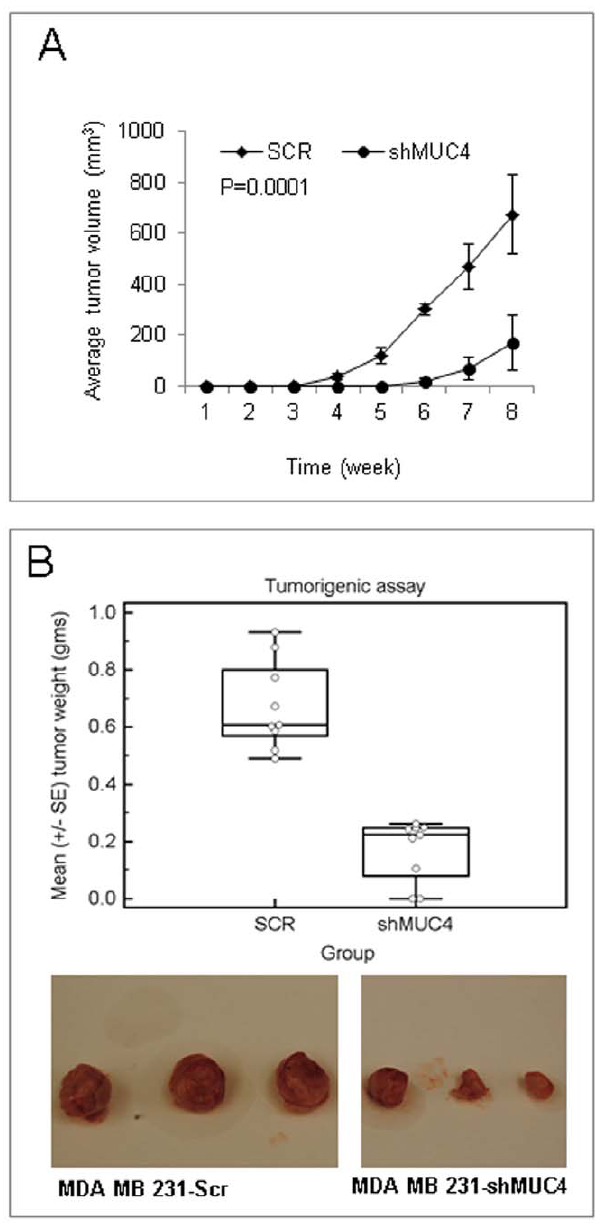
Figure 5. MUC4 promotes growth of MDA-MB-231 xenografts. ( A ) MUC4 knockdown and control cells (0.1 6 10 6 cells/animal) were orthotopically implanted in mouse mammary fat pad of each mouse (right 3 rd mammary gland). Tumor volumes were calculated every week. The MUC4 knockdown cells started to grow tumors during the 5 th week, but control cells started to grow tumors during the 3 rd week, p=0.0001. ( B ) Eight weeks after implantation, mice were sacrificed and tumors were excised and weighed. Stable silencing of MUC4 was found to decrease tumor growth, p=0.0001.